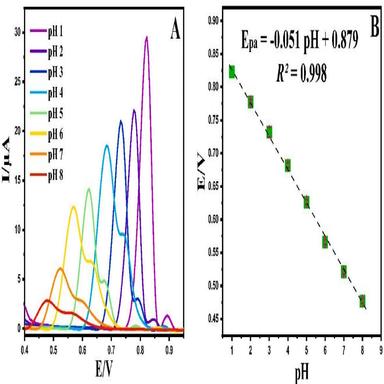
(A) Effect of pH on cyclic voltammograms of RIBO (pH 1–8), and (B) plot of E(V) versus pH for the electro-oxidation of 0.01 mM RIBO at the surface of LaNiO3/g-C3N4@RGH/GCE.